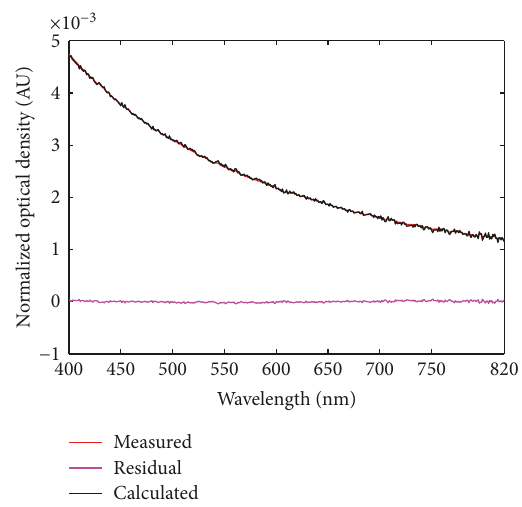
Figure 2: Comparison between measured and calculated normalized optical density spectra of E. coli in the wavelength range from 400 to 820 nm, the residuals are